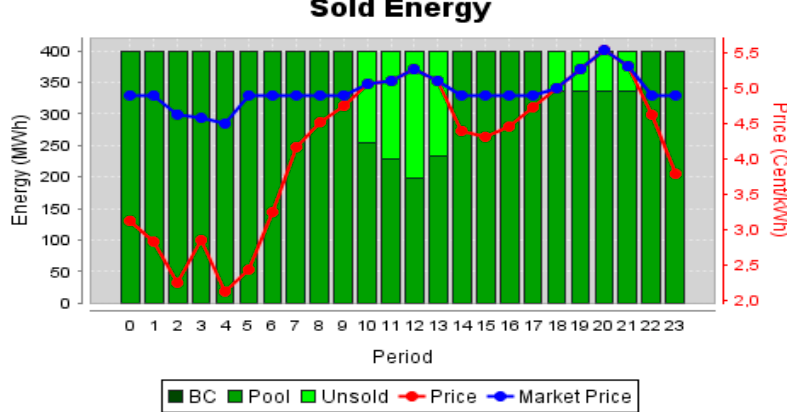
Figure 16. Energy sold on the market considering the results of the steam sale.